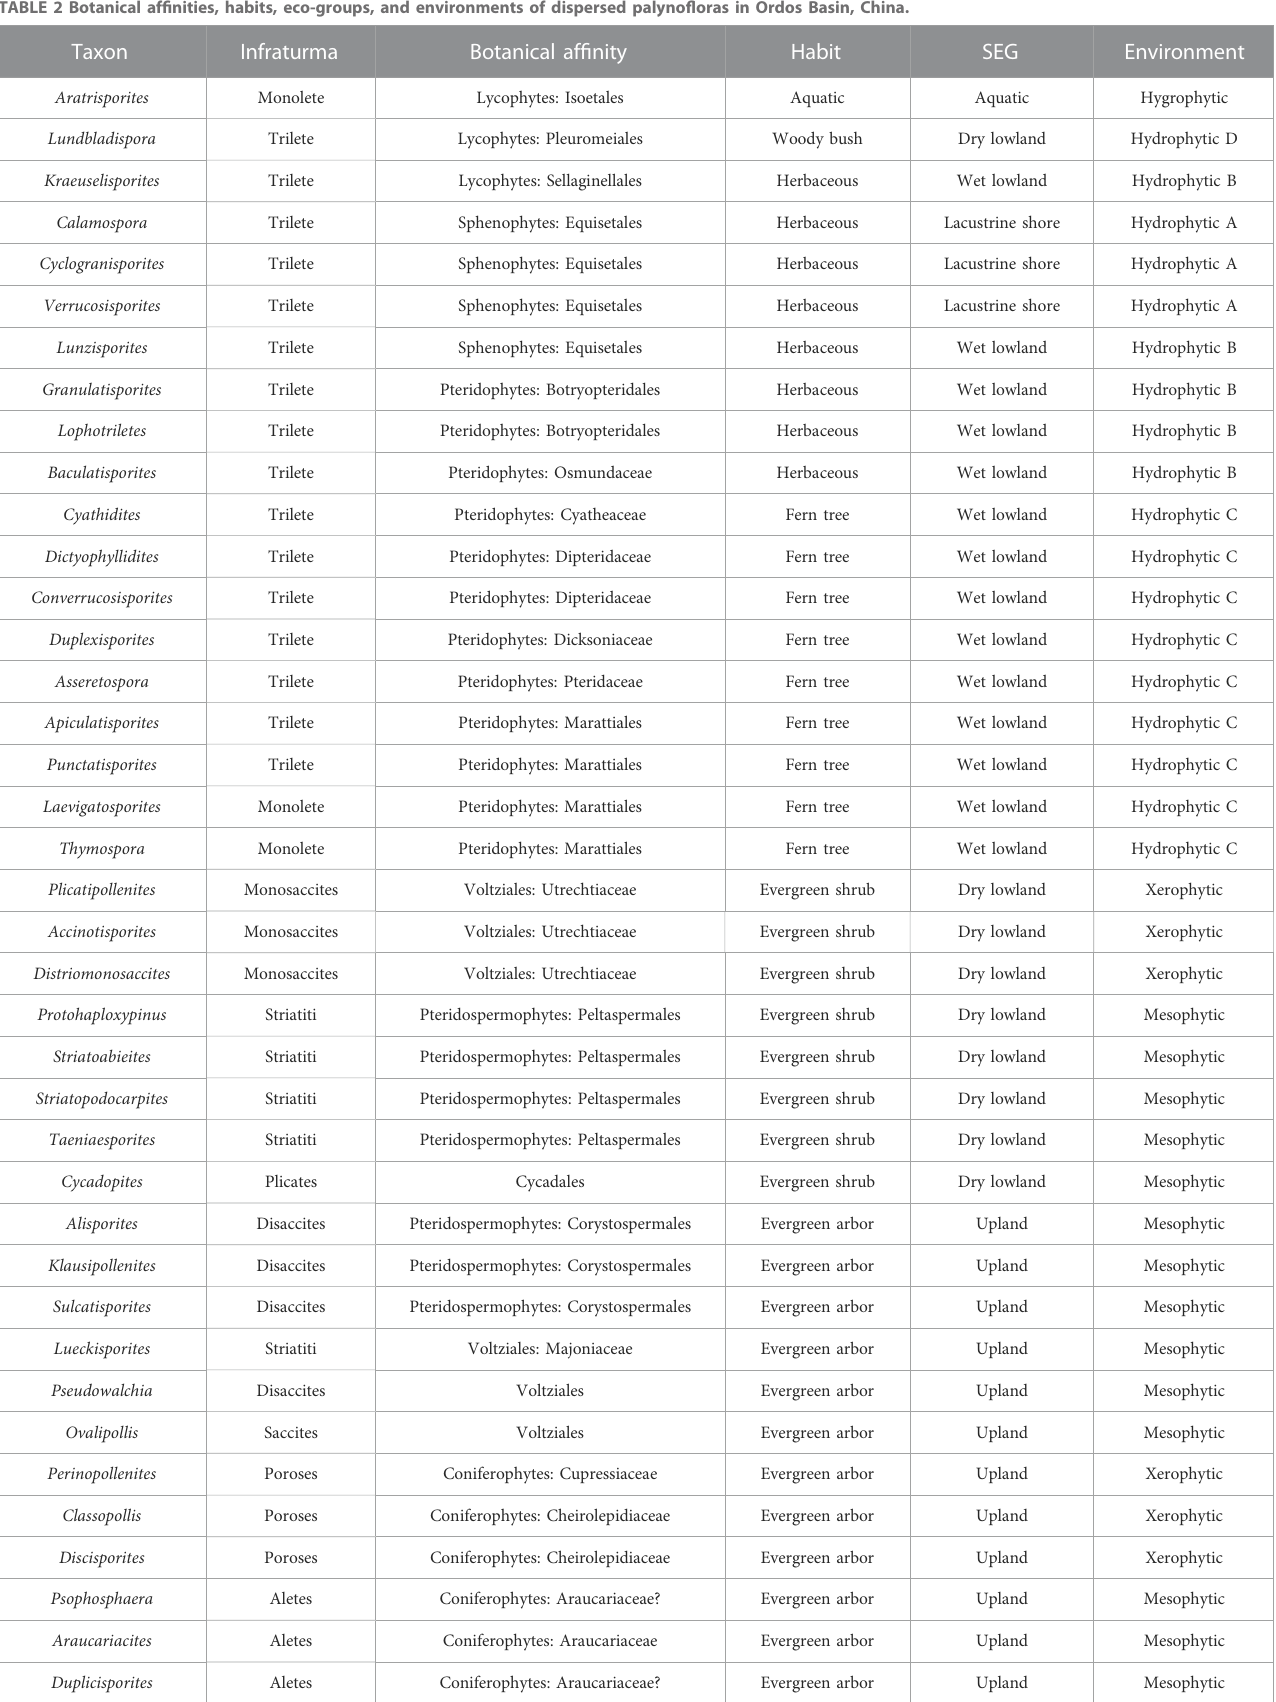
TABLE 2 Botanical af fi nities, habits, eco-groups, and environments of dispersed palyno fl oras in Ordos Basin, China.